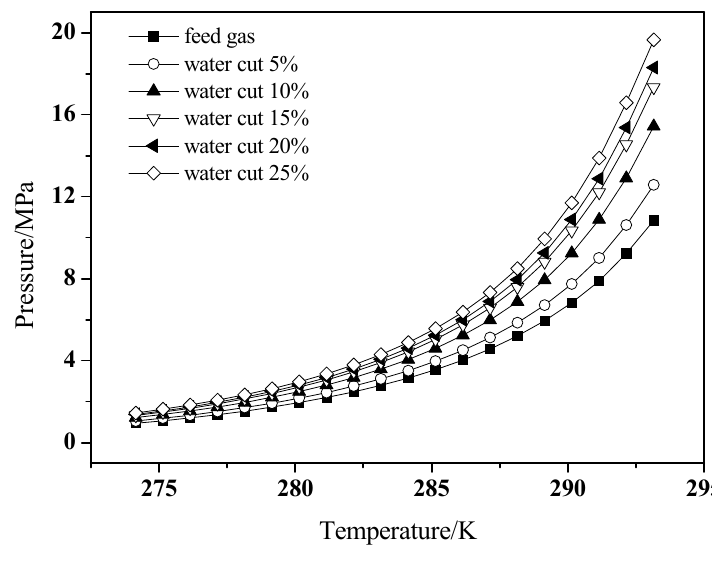
Figure 8. Hydrate formation condition of equilibrium gases for different water